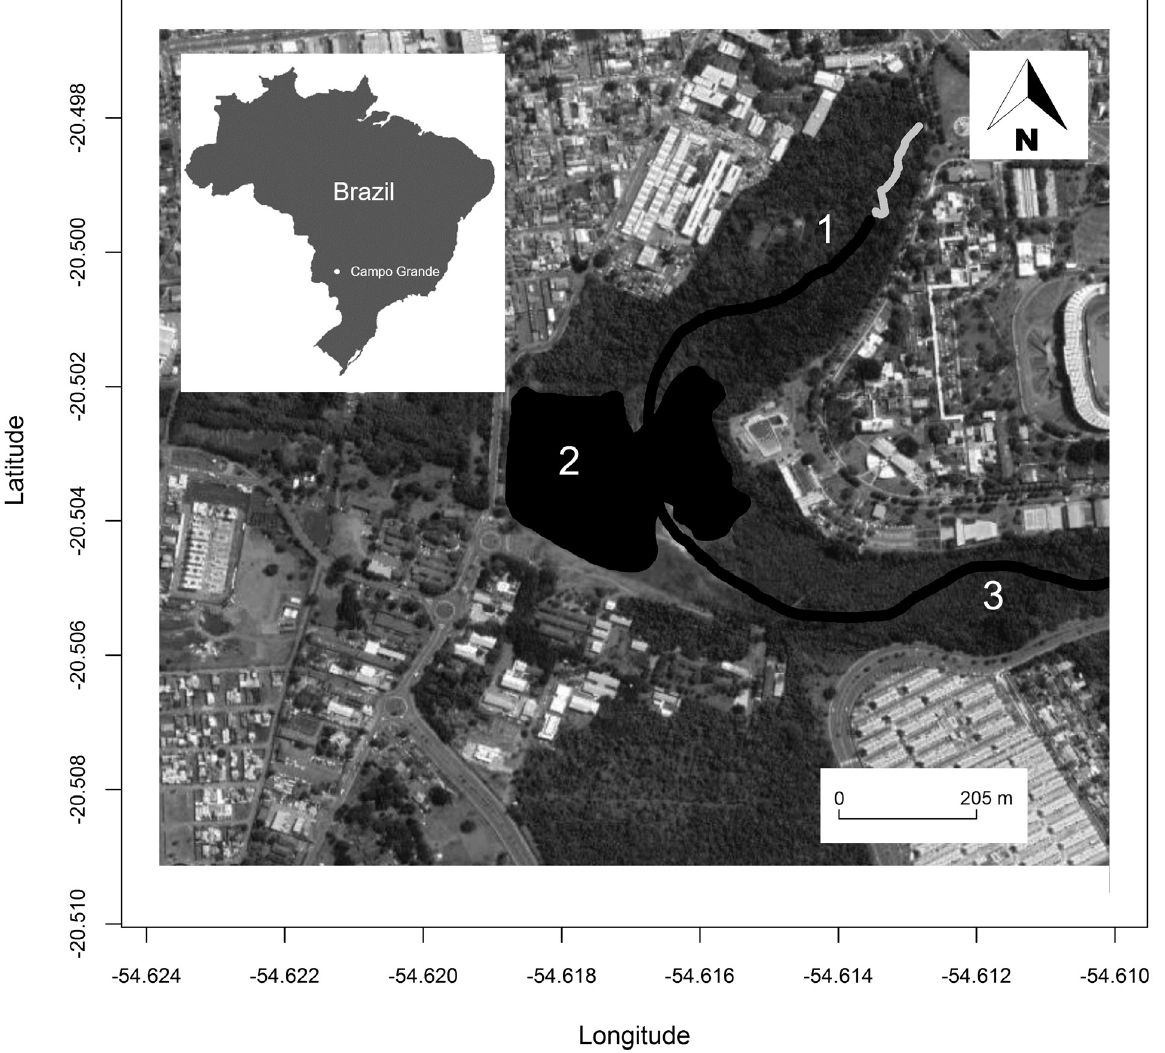
Figure 1. Study area at RPPN-UFMS (Campo Grande, MS, Brazil). 1. Cabaça Stream; 2. Amor Lake; 3. Bandeira Stream; Black area – the three water bodies used by Phrynops geoffroanus ; White area – the 200 m stretch of Cabaça Stream where individuals were initially captured; Vertical axis – Latitude; Horizontal axis –